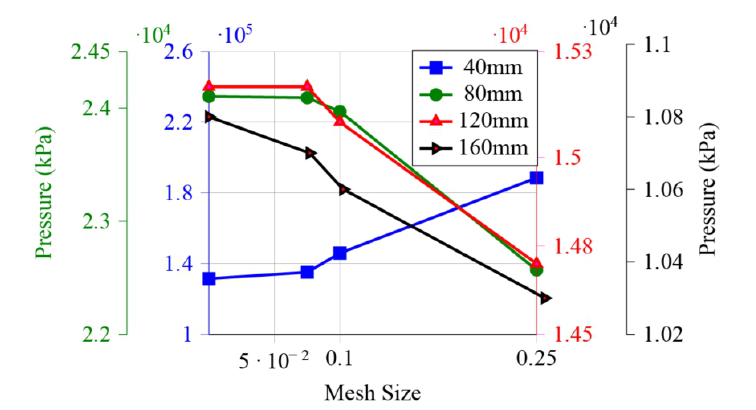
Figure 7. Calculation of grid convergence index for near-field.